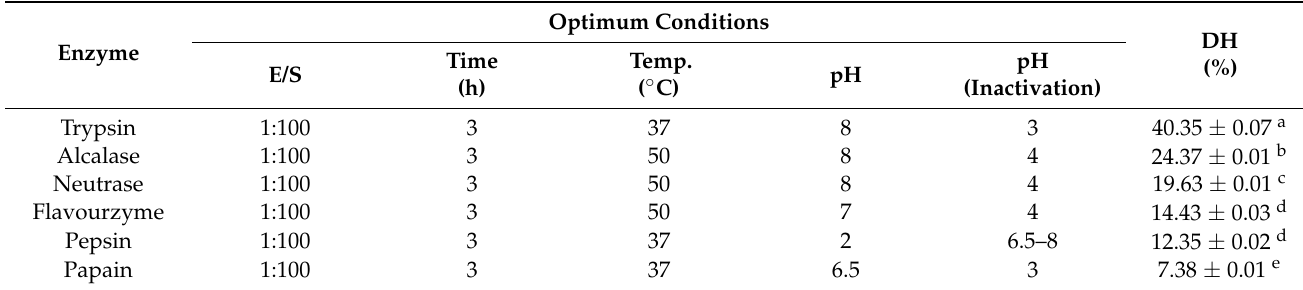
Table 1. Hydrolysis conditions and degree of hydrolysis of Sturgeon fish skin collagen with various commercial proteases. Optimum Enzyme